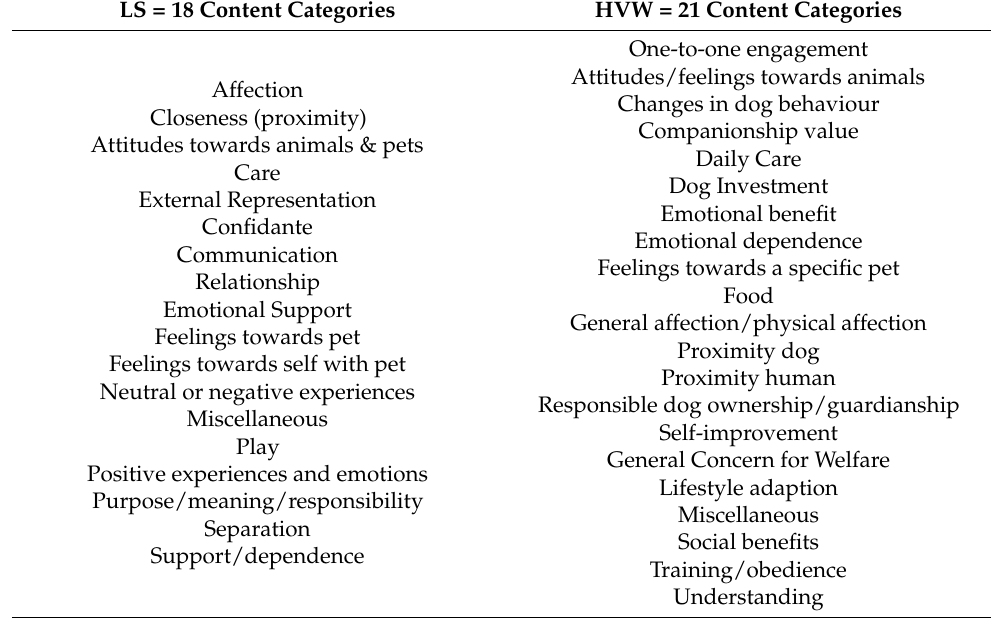
Table 4. Results of independent content categorisation by two researchers (LS and HVW) for 228 ques- tions related to the human–dog bond (HDB). The 228 questions can be seen in Supplementary Materials, Table S1.